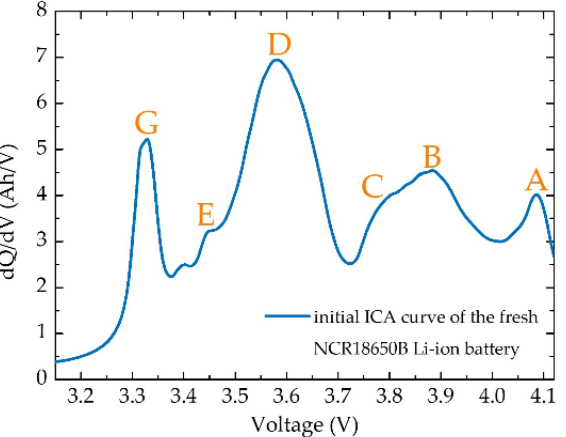
Figure 10. ICA curve of the fresh NCR18650B battery with seven features recognised and labelled.